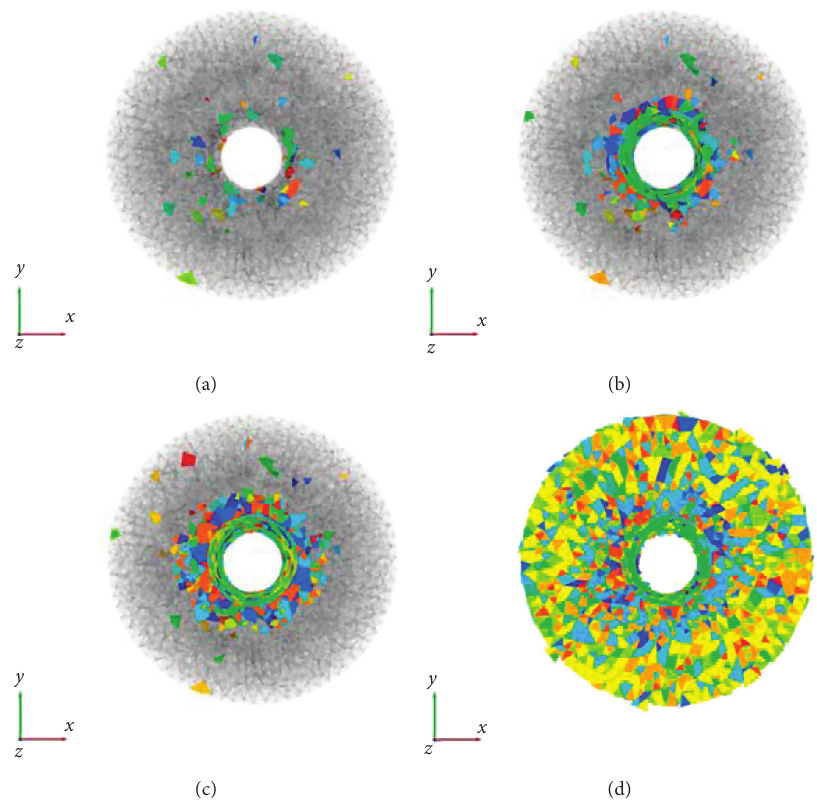
Figure 9: Top view of the rock fragments at four different states for the TWC test with intact rock